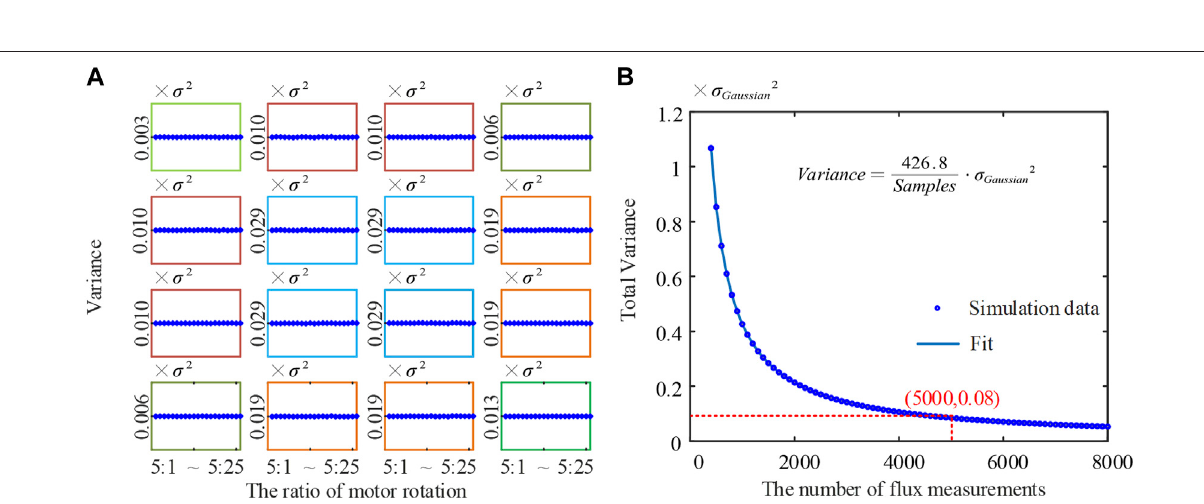
Frontiers in Physics |